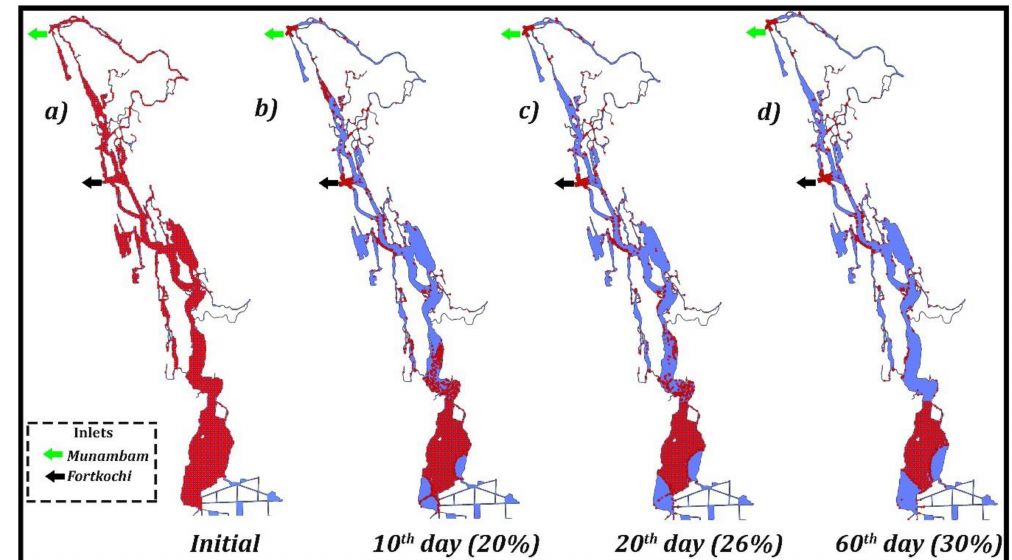
Figure 15. Spatial distribution of particles after the initial period ( a ), with 20% ( b ), 26% ( c ) and 30% ( d ) of the particles flushed out from the model domain with varying climatological freshwater discharge at the upstream boundaries during the pre-monsoon.